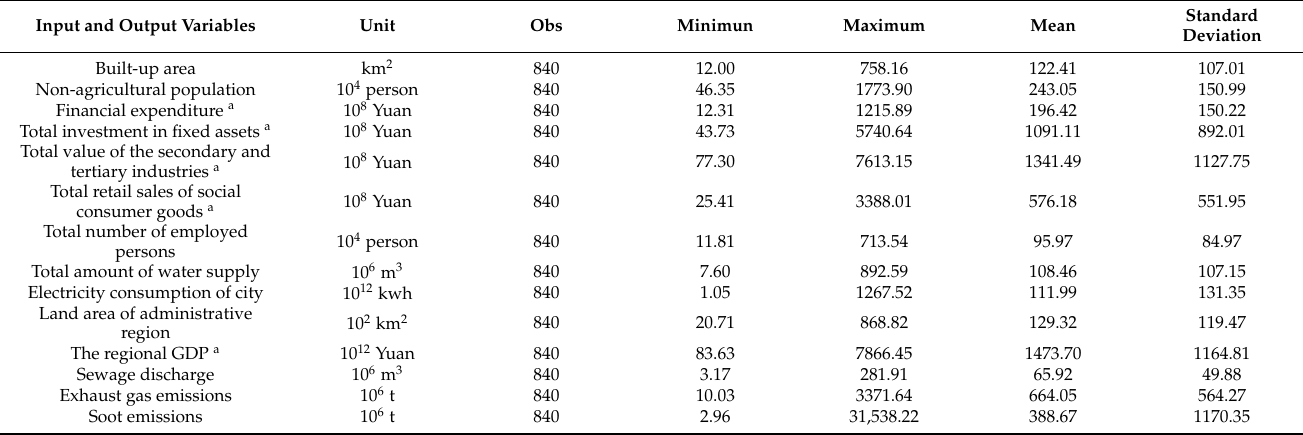
Table 2. Descriptive statistics of input and output